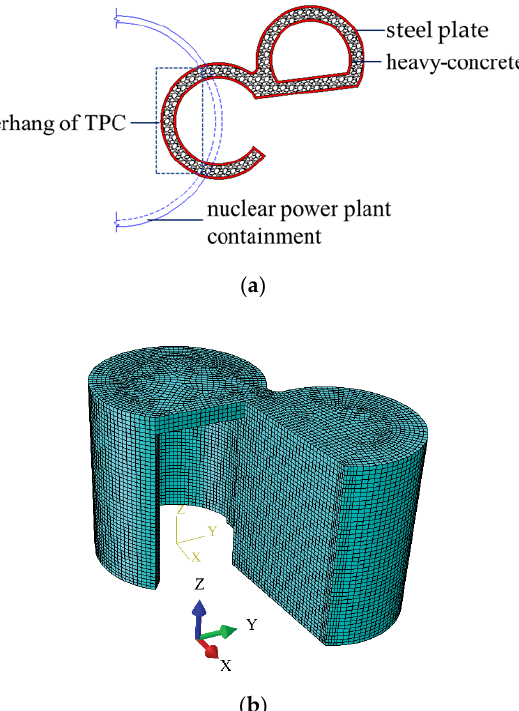
Figure 2. The location and the finite element model of the TPC. ( a ) The location of TPC. ( b ) The finite element model of the TPC.